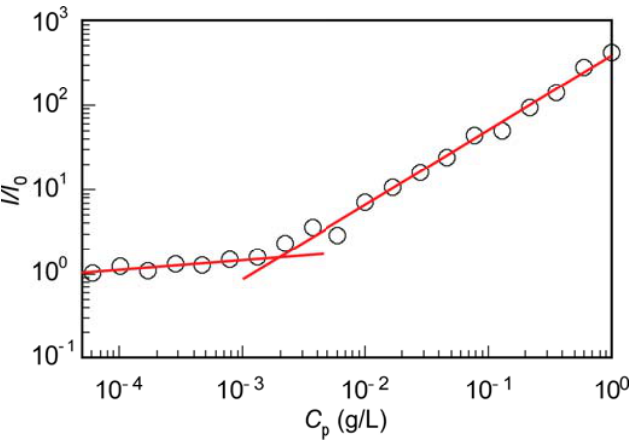
Figure 6. Light scattering intensity ratio ( I / I 0 ) for the aqueous PIC micelles containing 0.1 M NaCl as a function of polymer concentration ( C p ). I and I 0 are the light scattering intensities of the solution and solvent, respectively.